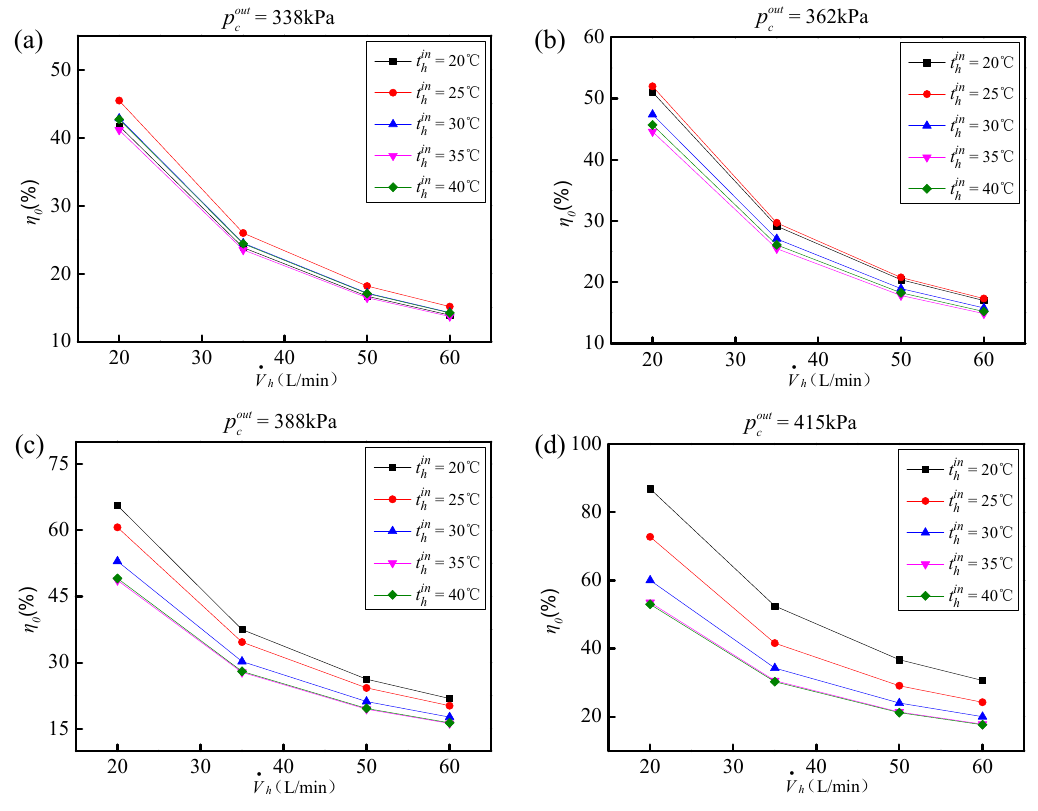
η out 0 and p c for given t